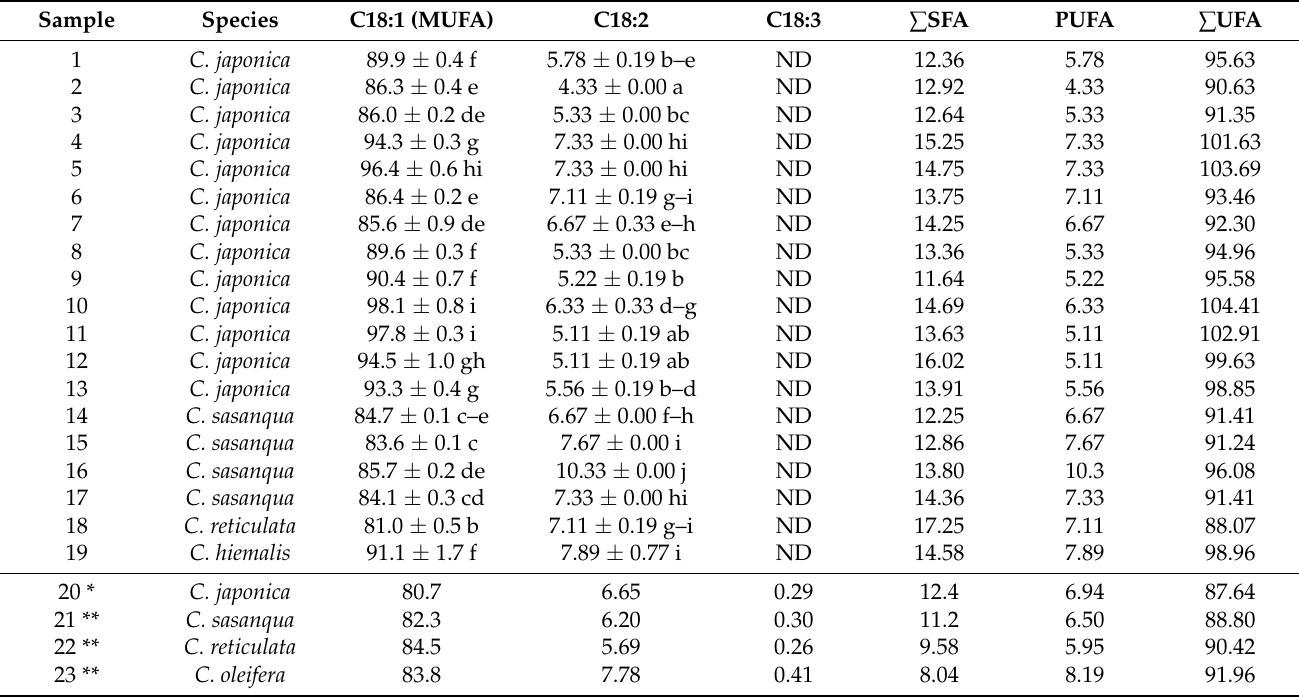
Table 4. FAs composition by 1 H-NMR, expressed as % total fatty acids.